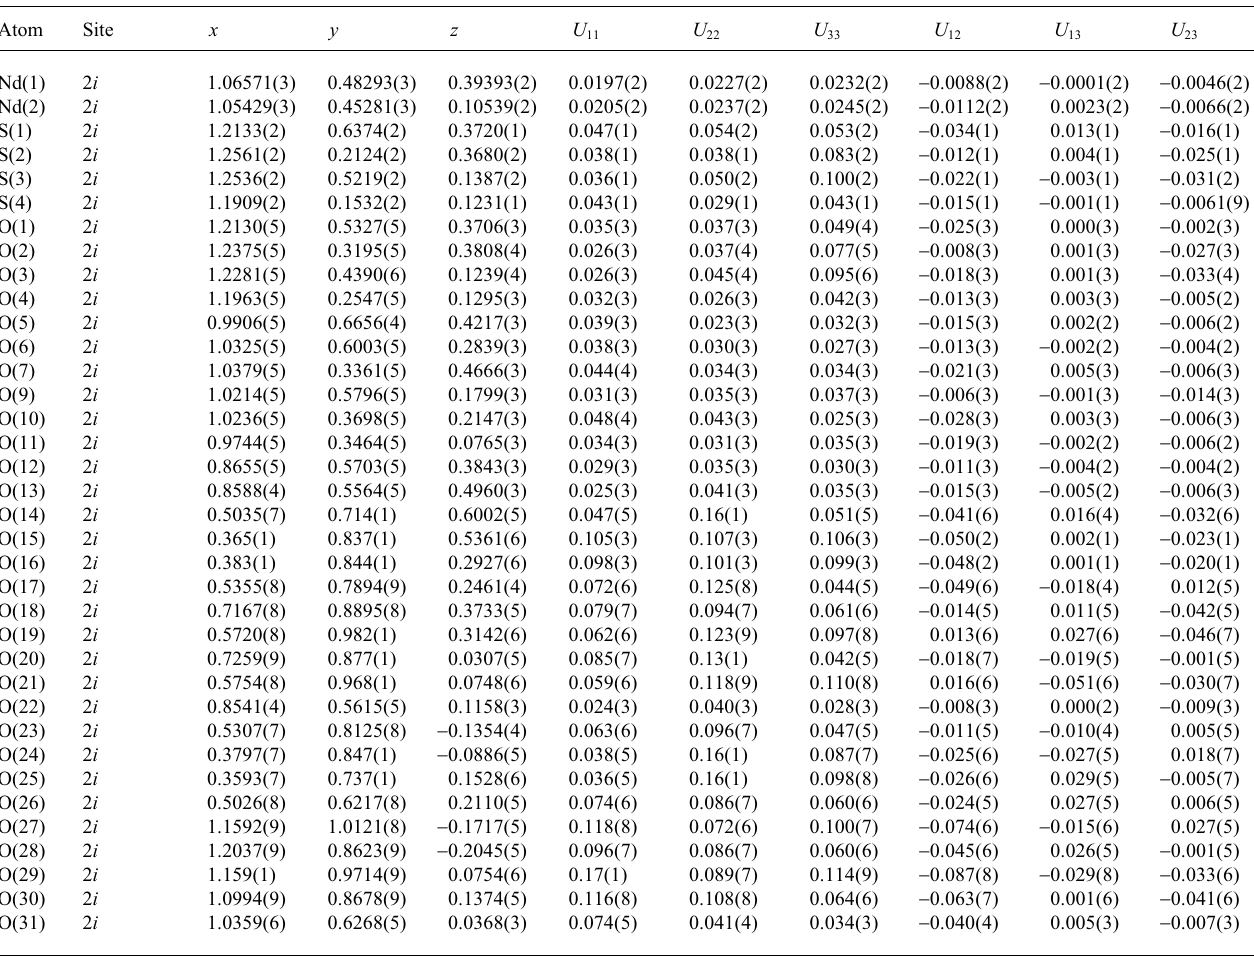
Table 3. Atomic coordinates and displacement parameters (in Å 2 ) .